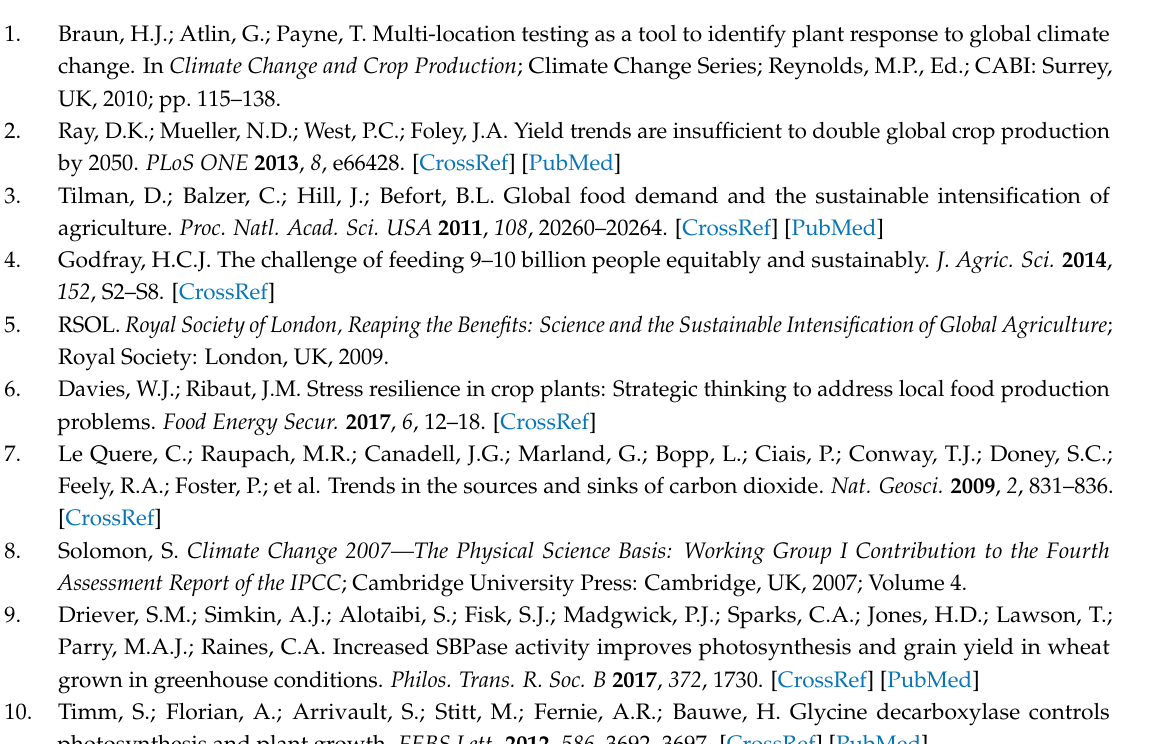
Figure S1. Schematic of transcriptional gene fusion construct of the B. distachyon SBPase and FBPA promoters with the β -glucuronidase ( gus ) reporter for expression analysis in N. benthamiana leaves. Genomic DNA of B. distachyon leaves was used to amplify the native promoters of SBPase and FBPA. They were cloned into the pENTR vector (Invitrogen). The resulting product was transferred into the (a) pGWB3 vector by LR recombination to make (b) pGW:pSBPase::GUS and (c) pGW:pFBPA::GUS, Figure S2. Schematic of transcriptional gene fusion constructs of the B. distachyon SBPase and FBPA promoters with the β -glucuronidase ( gus ) reporter for expression analysis in wheat leaves. Genomic DNA of B. distachyon leaves was used to amplify the native promoters of SBPase and FBPA and they were cloned into the corresponding restriction sites (pSBPase was cloned into the Mlul and AscI restriction sites and pFBPA was cloned into the EcoRI and XmaI restriction sites) of the (a) pRRes14.041::GUS vector to make (b) pRRes:pSBPase::GUS and (c) pRRES:pFBPA::GUS, Figure S3. Schematic of transcriptional gene fusion constructs of the B. distachyon SBPase and FBPA promoters and coding sequences fused to the cytochrome c 6 -FLAG sequence for expression analysis in wheat leaves. The cytochrome c 6 -FLAG-tagged protein was cloned into the NcoI and EcoRV restriction sites of vector pRRes:pSBPase::GUS and pRRes:pFBPA::GUS, simultaneously removing the intron and gus reporter gene to generate (a) pSBPase::FLAG and (b) pFBPA::FLAG respectively, Figure S4. Sequence and regulatory motifs in the 2 kb upstream region of the B. distachyon SBPase gene. The different coloured boxed sequences represent the promoter motifs (see Figure 1), Figure S5. Sequence and regulatory motifs in the 2 kb upstream region of the B. distachyon FBPA gene. The different coloured boxed sequences represent the promoter motifs (see Figure